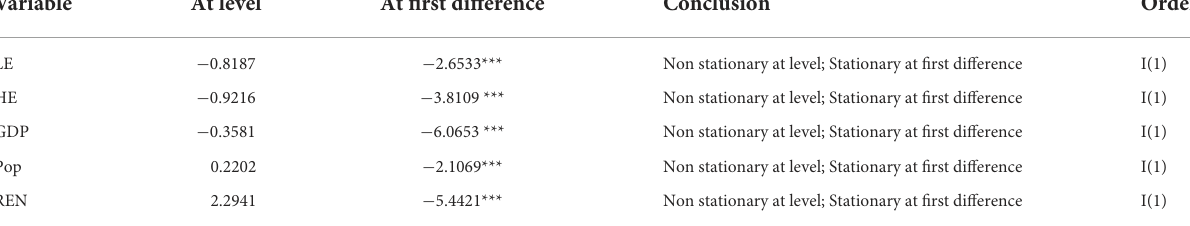
TABLE 1 ADF unit root